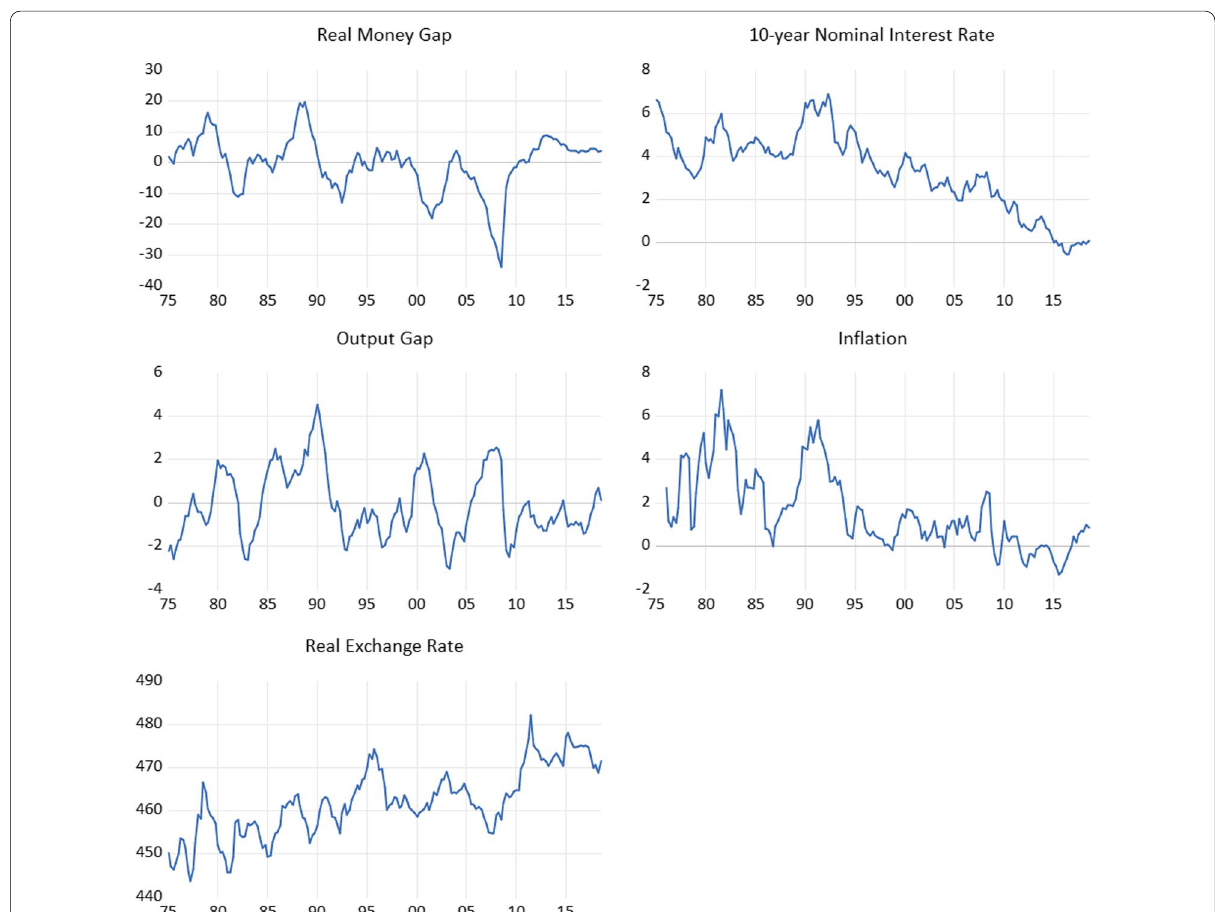
Fig. 3 Real money gap, long-term interest rate, output gap, inflation and real exchange rate, 1976–2018